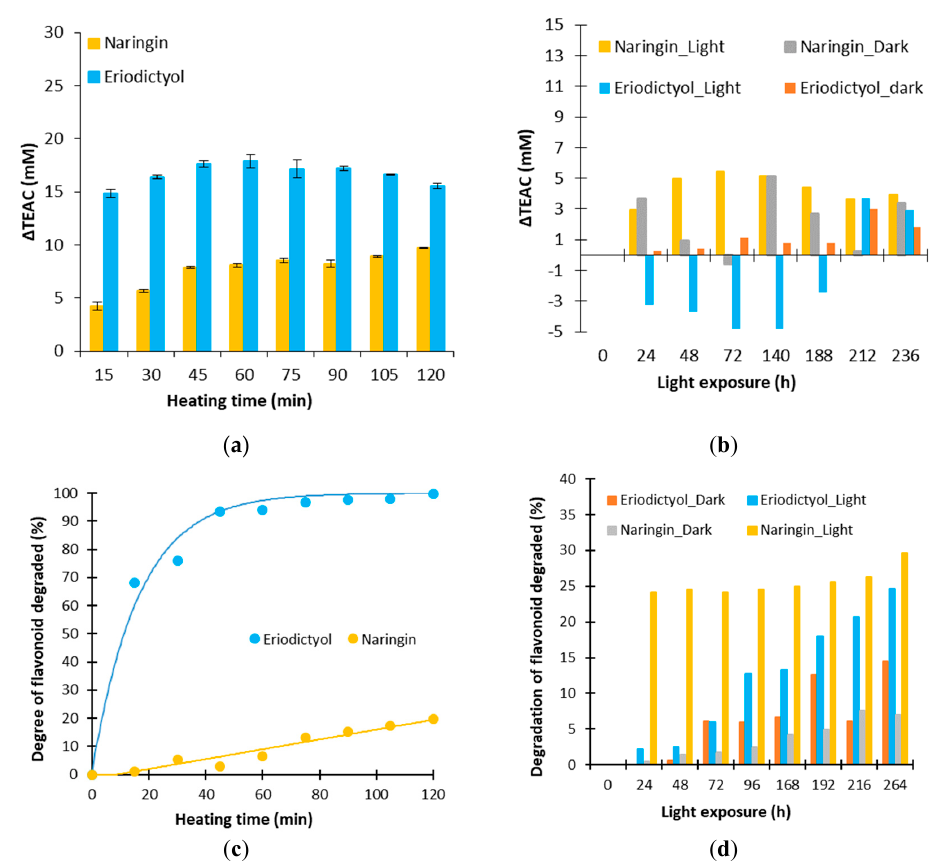
Figure 3. Evolution of ∆ TEAC and percentage of flavonoid degraded for naringin and eriodictyol for a thermal treatment of 130 ◦ C ( a , c ) and an exposure to light ( b , d ).